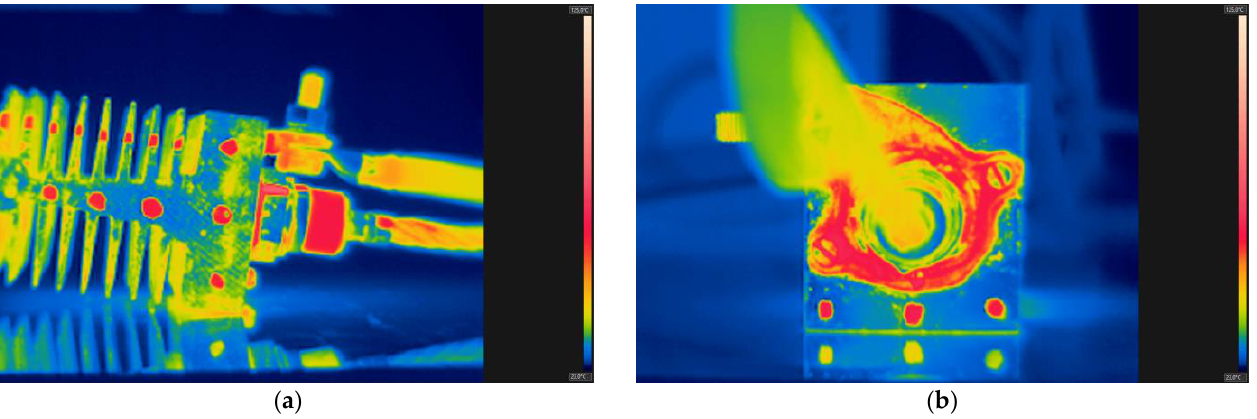
Figure 7. The thermograms showing a heat sink for a power of P j = 74.36 W: ( a ) side view; ( b ) top view. The temperature on the thermogram ranges from 23 °C to 125 °C.